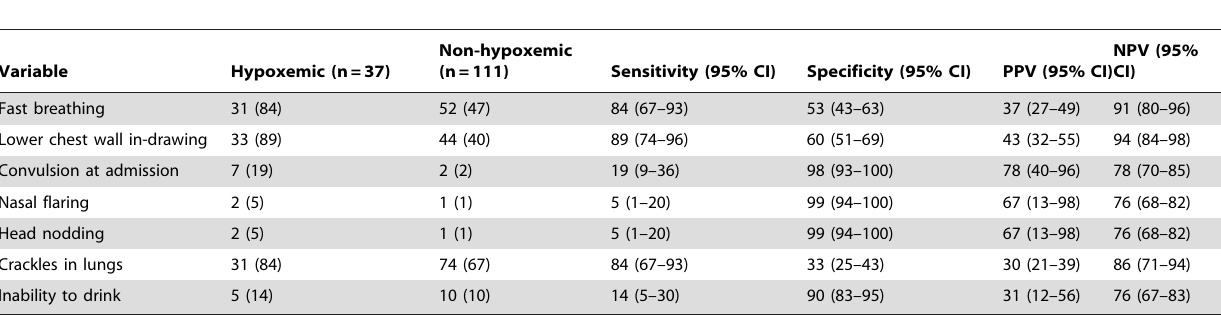
Table 3. Sensitivity, specificity, positive and negative predictive value of predictors of hypoxemia in the severely malnourished children with